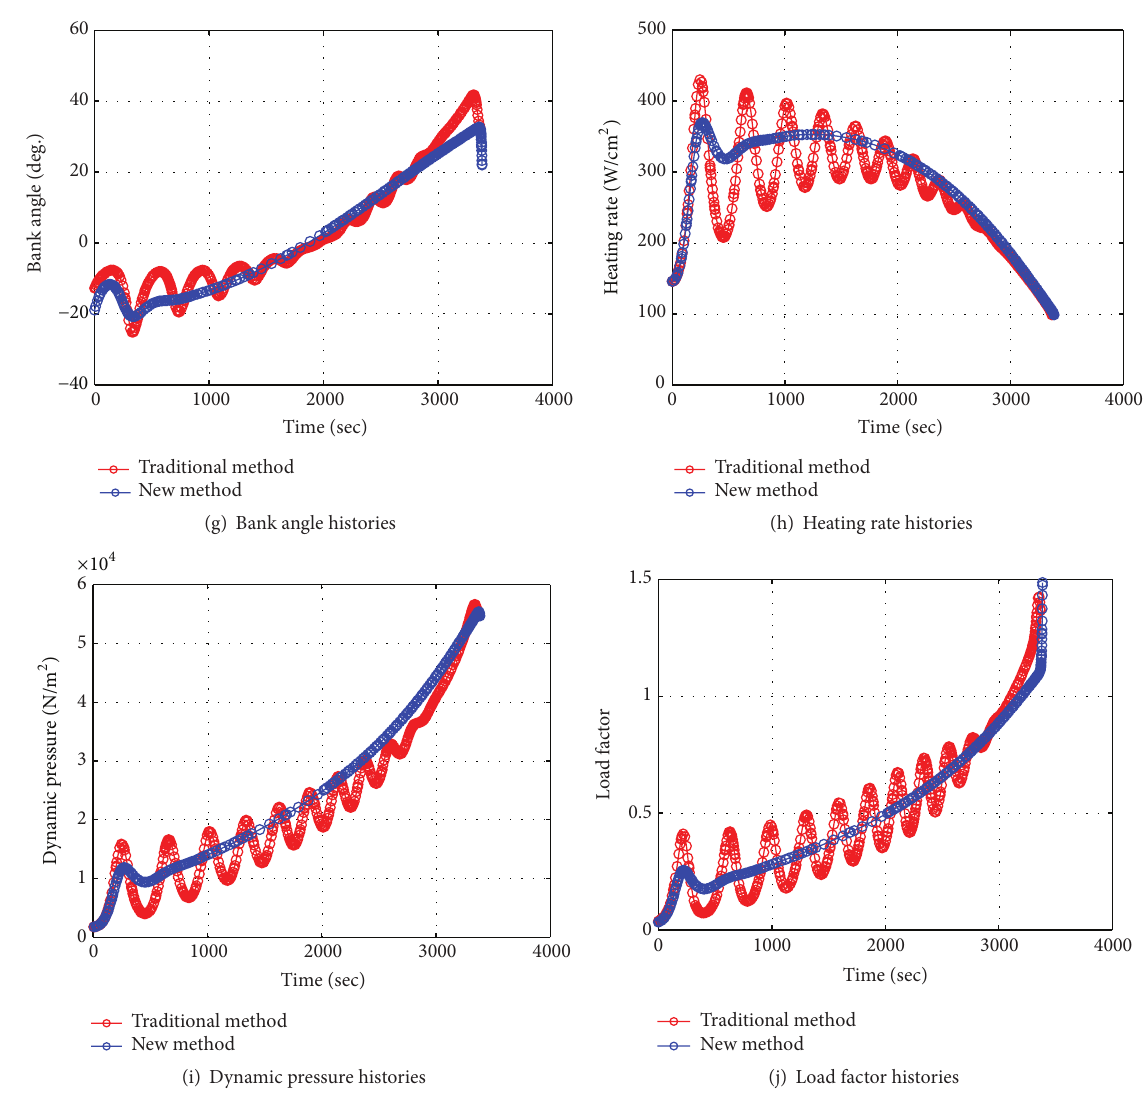
Figure 3: Numeric results of Steady Glide Trajectory Optimization without Bank Reversal. Table 1: Initial and final conditions for different